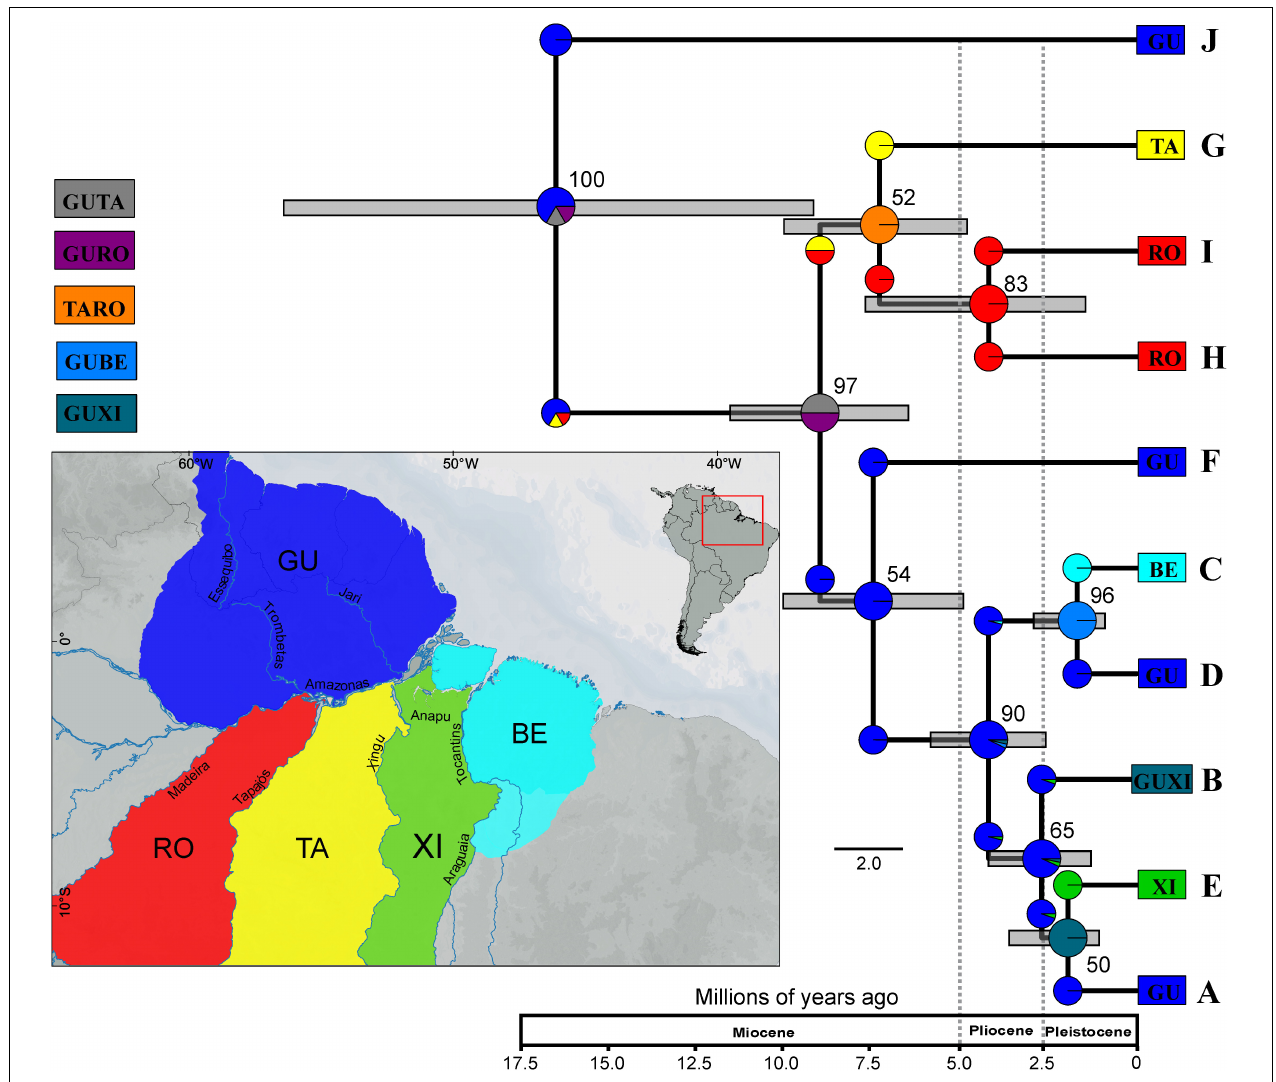
FIGURE 4 | Species tree based on markers CYTB, 16S, and SINCAIP using *BEAST and biogeographic reconstruction inferred using BioGeoBEARS for Kentropyx calcarata . We consider five areas: GU–Guiana (dark blue), BE–Belém (light blue), XI–Xingu (green), TA–Tapajós (yellow), and RO–Rondônia (red). The resulting best-fit model for our phylogeny was DIVALIKE (lnL = –22.06, AIC = 48.13). Clades correspond to populations/lineages defined by phylogeographic analysis. The numbers in the nodes correspond to the values of posterior probability (pp). Color of each group correspond to those of Figures 1 , 2 . Time scale represents millions of